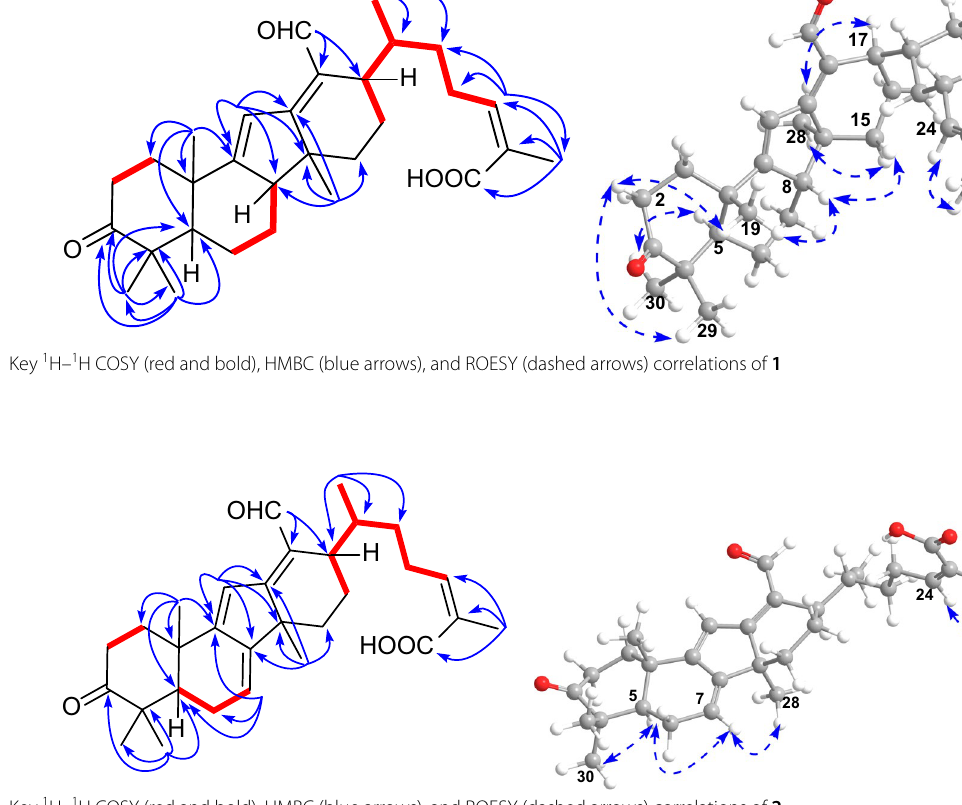
Fig. 3 Key 1 H– 1 H COSY (red and bold), HMBC (blue arrows), and ROESY (dashed arrows) correlations of